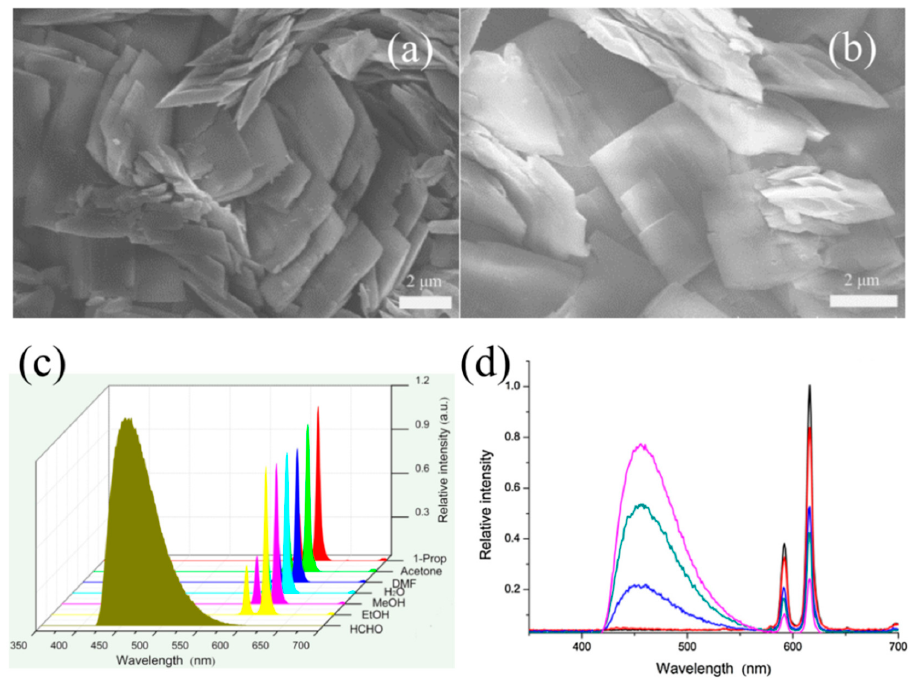
Figure 22. SEM images of Eu-NDC@HPAN: ( a ) top view and ( b ) enlarged view of ( a ); ( c ) Luminescence spectra of Eu-NDC@HPAN treated with different small molecules; ( d ) Luminescence spectra of Eu-NDC@HPAN as a function of the formaldehyde concentrations (from top to bottom: 1, 0.5, 0.25, 0.1, 0.05%) in aqueous solutions. Reprinted with permission from Reference [123]. Copyright 2017 Elsevier.